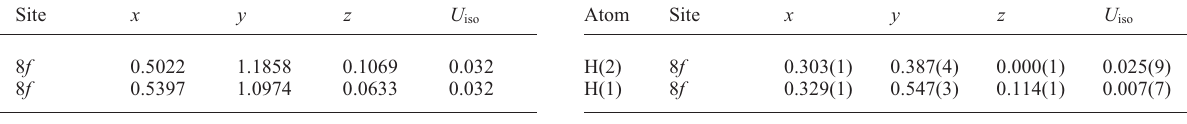
Table 3. Atomic coordinates and displacement parameters (in Å 2 )